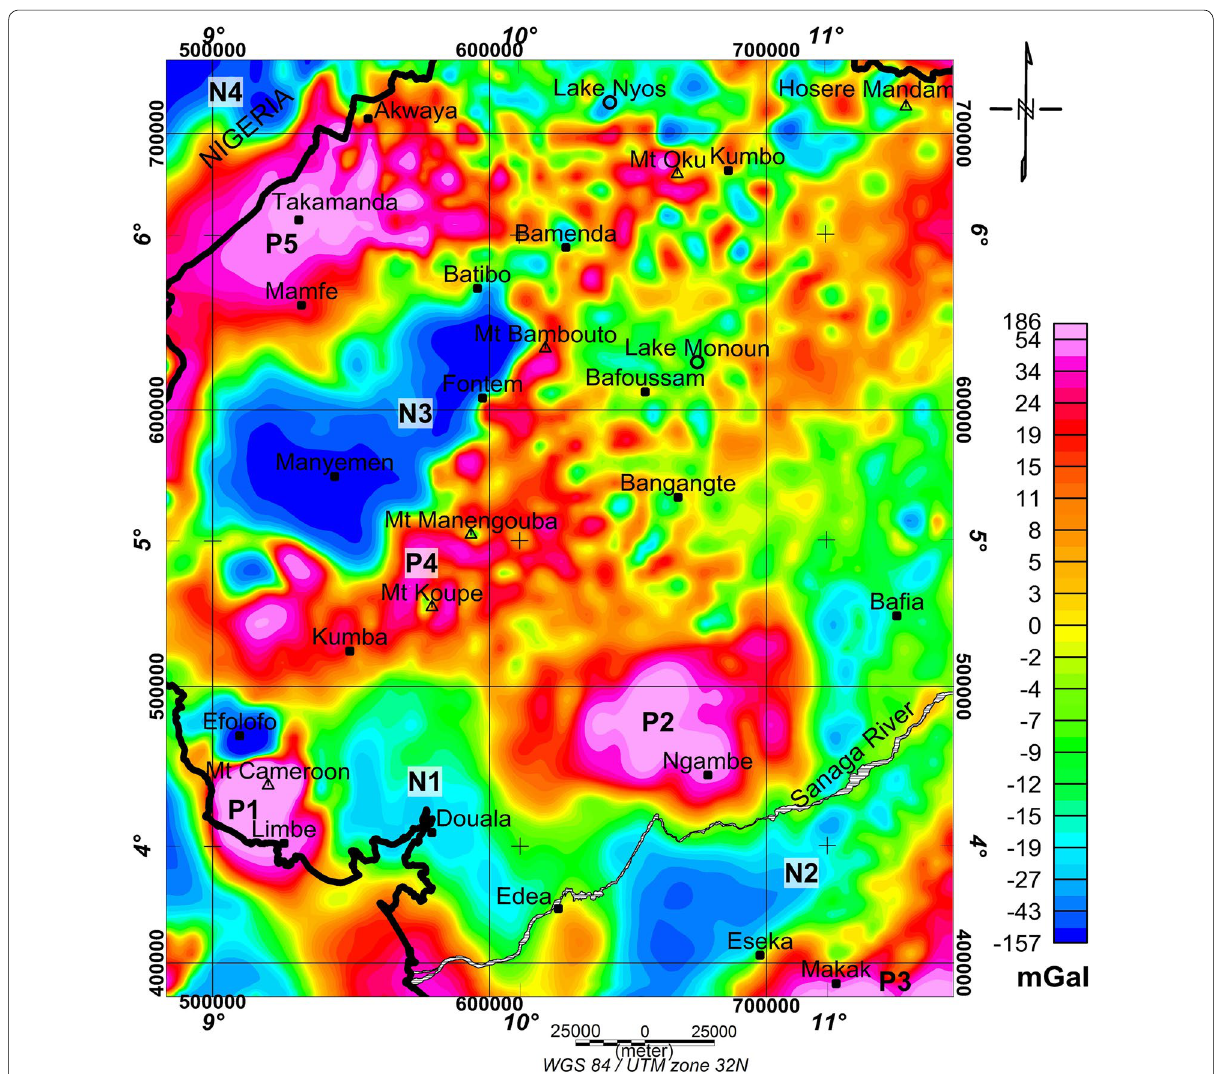
Fig. 5 Residual anomaly map of the study area. (modified from Marcel et al.